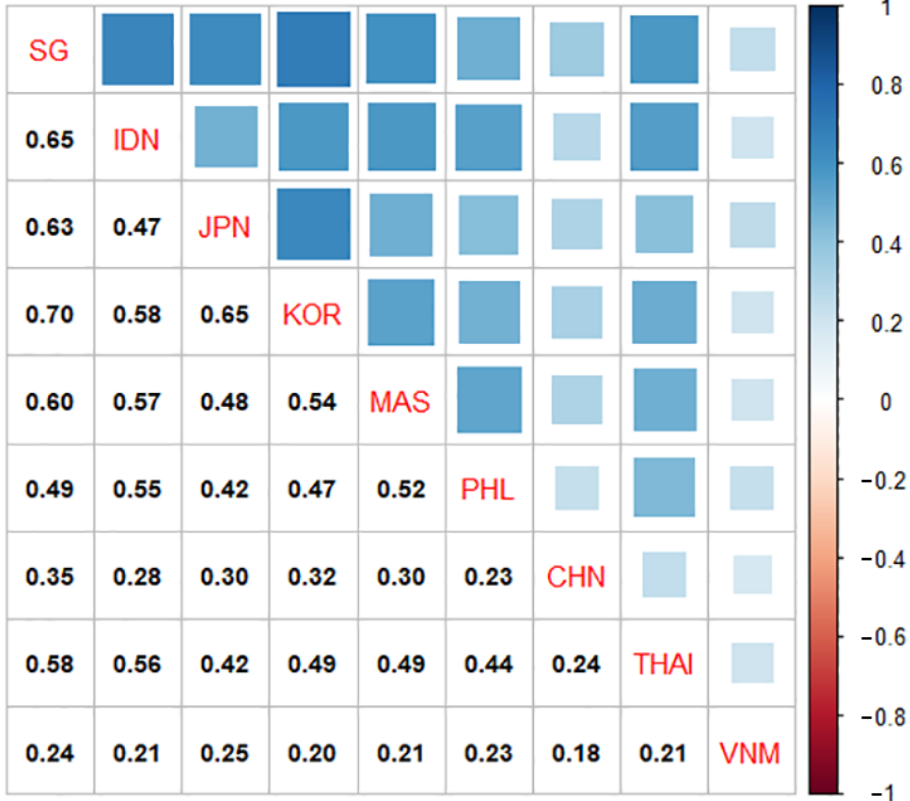
Figure 2. Heat map of the correlation. This figure shows a visual correlation matrix across asset returns for ASEAN+3. The magnitude of correlations is shown by the color intensity of the shaded boxes. Blue denotes positive correlation, while red denotes negative correlation. Please refer to Table 1 for abbreviations of ASEAN+3 countries. All correlations are significant at a 1% level.